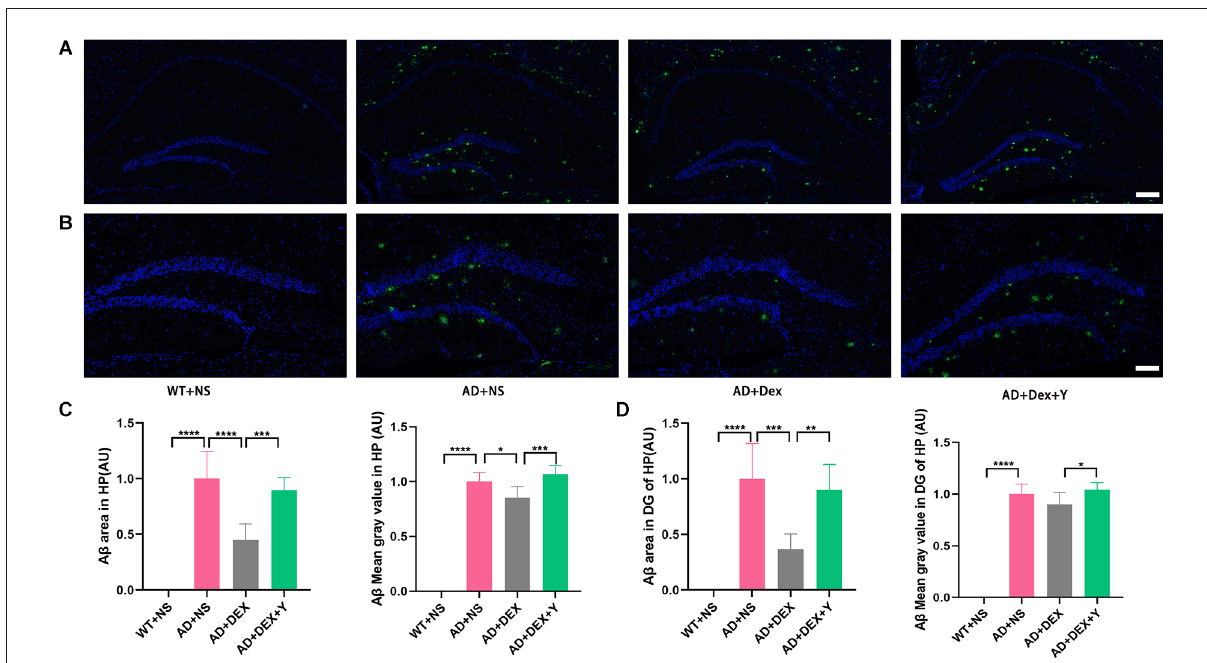
FIGURE2 Dexmedetomidine alleviates the deposition of A β (A,B,C,D) (means ± SD, ANOVA, * p < 0.05, ** p < 0.01, *** p < 0.001, **** p < 0.0001). (A) Immunofluorescence staining of hippocampal sections from WT and 5xFAD mice, scale bars, 200 µ m. (B) Immunofluorescence staining of the